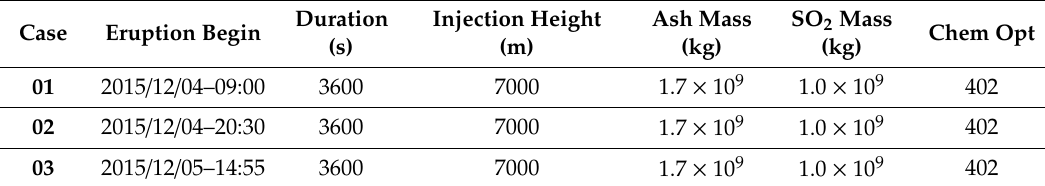
Table 2. Eruption source parameters and chemistry setup. The total amount of volcanic ash has been calculated through Equation (1).